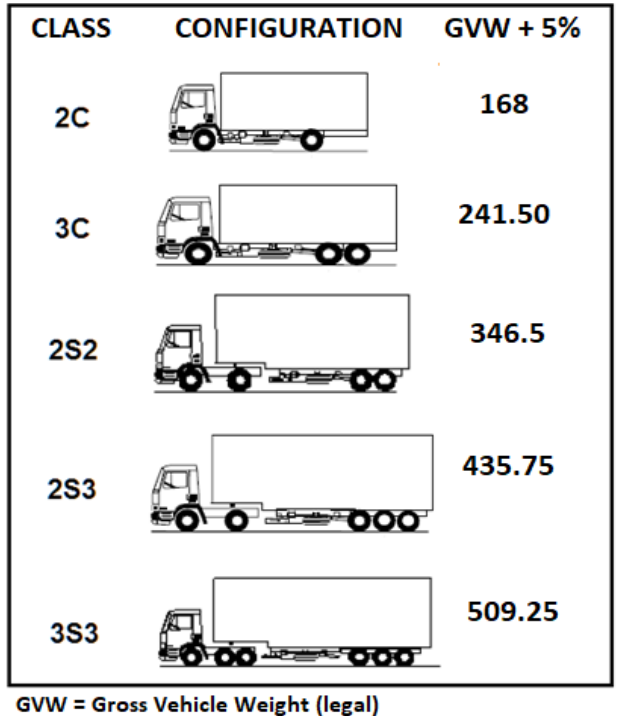
Figure 7. Frequent classes with the respective legal